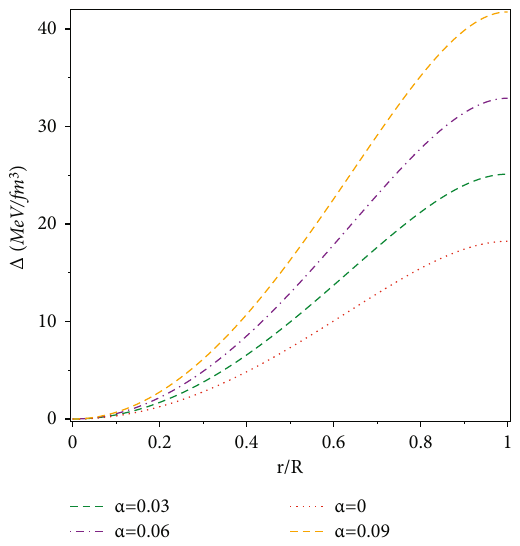
Figure 3: The variation of temperature ( T ) with the radial = 83 coordinate for the strange star SMCX-4, where B g R = 9 : 711 km, and M = 1 : 29 M ⨀